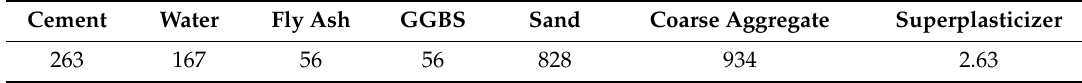
Table 4. Mix composition of ready-mixed concrete (unit: kg / m 3 ).